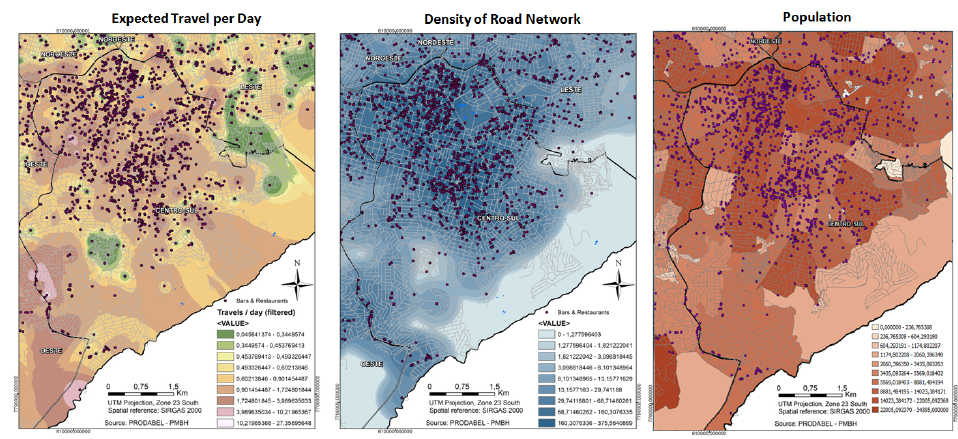
Figure 6: Overview of downtown Belo Horizonte using GIS maps used to improve the spatial analysis: the interpolated surface resulting from the trip generating model (left),the density of road network (center) and amount of population per neighborhood (right) implementation of a less restrictive and more efficient public policy, to consolidate the goods and reduce the number of freight vehicles in urban